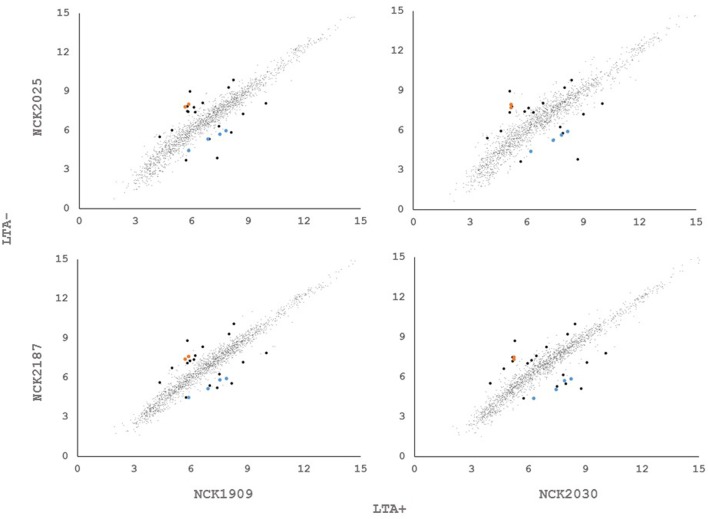
XY plots of log2 transformed, normalized transcripts per kilobase million (TPM) metric of open reading frames in Lactobacillus acidophilus. Black data points meet the significance thresholds p < 1.36e-5, α = 0.05) and fold change (>2) in each pairwise comparison. Colored data points indicate differentially expressed genes in operons.